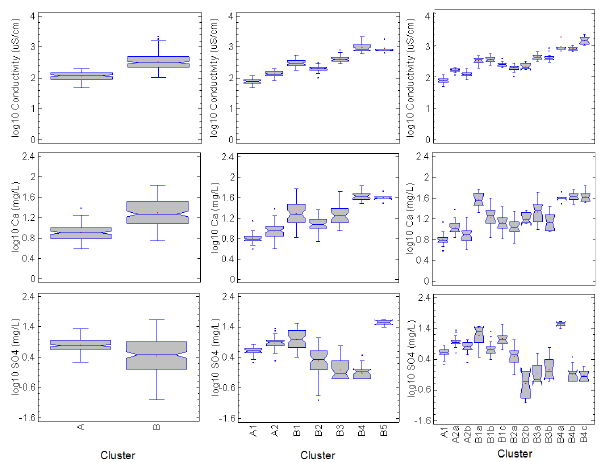
Figure 8. Box-Whisker plots showing the variations in electrical conductivity, Ca and SO 4 2 Fig. 8. Box-Whisker plots showing the variations in electrical con- across the two, seven or thirteen clusters defined at different separation thresholds shown in 3 ductivity, Ca and SO 4 across the two, seven or thirteen clusters de- Figure 4. 4 fined at different separation thresholds shown in Fig. 4.